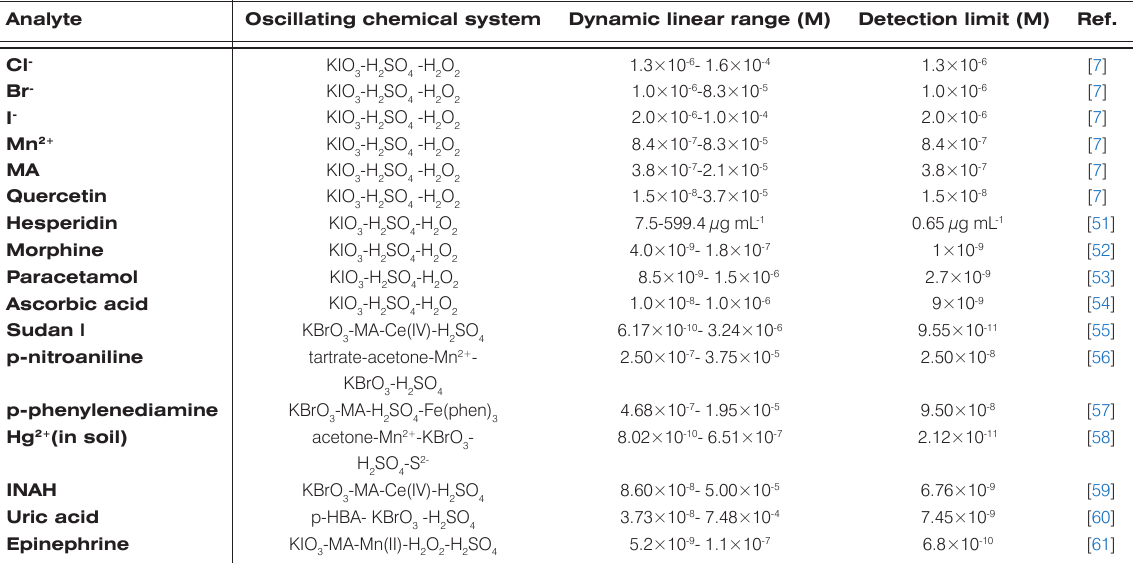
Table 4. Use of non-equilibrium species